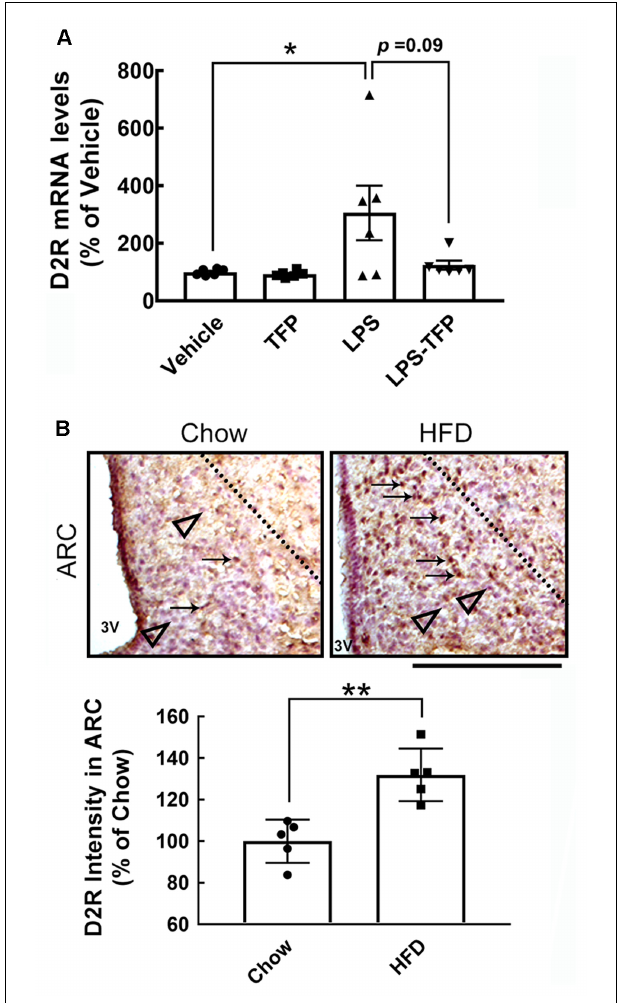
FIGURE 3 | Increased expression of D2R in the hypothalamus after acute peripheral LPS injection or chronic HFD feeding. (A) Mice were injected peripherally with the vehicle, TFP (2 mg/kg), LPS (1 mg/kg), or LPS plus TFP as described in the Materials and Methods. The hypothalamic tissues were removed at 6 h post injection for RNA extraction and QPCR analysis to determine the D2R mRNA expression. Each dot represents one animal. The results are presented as the mean ± SEM ( n = 4 animals for each group). Although D2R expression in the LPS-treated group was not biostatistically greater than that detected in the LPS-treated group ( P = 0.09), its expression displayed an upregulated trend. (B) Mice were sacrificed at 12 weeks after feeding with chow or HFD. Brain sections were prepared as described in the “Materials and Methods” section and subjected to immunohistochemistry for D2R expression. The arrows indicate D2R + cells (brown) in the ARC, which mostly accumulate in HFD-fed mice. The observations were confirmed by quantification of D2R immunoreactive intensity in the ARC. The representative D2R — cells (purple blue) are shown by arrowheads below the dashed line. Each dot represents one immunostained hypothalamic tissue section. The results are presented in (A) and (B) as the mean ± SEM ( n = 5–6 animals for each group). Each dot represents one animal. 3V, 3rd ventricle. * p < 0.05 vs. Vehicle (A) , ** p < 0.01 vs. Chow (B) . Scale bar in (B) , 100 µ m. HFD, high-fat-diet; D2R, dopamine D2 receptor; ARC, arcuate